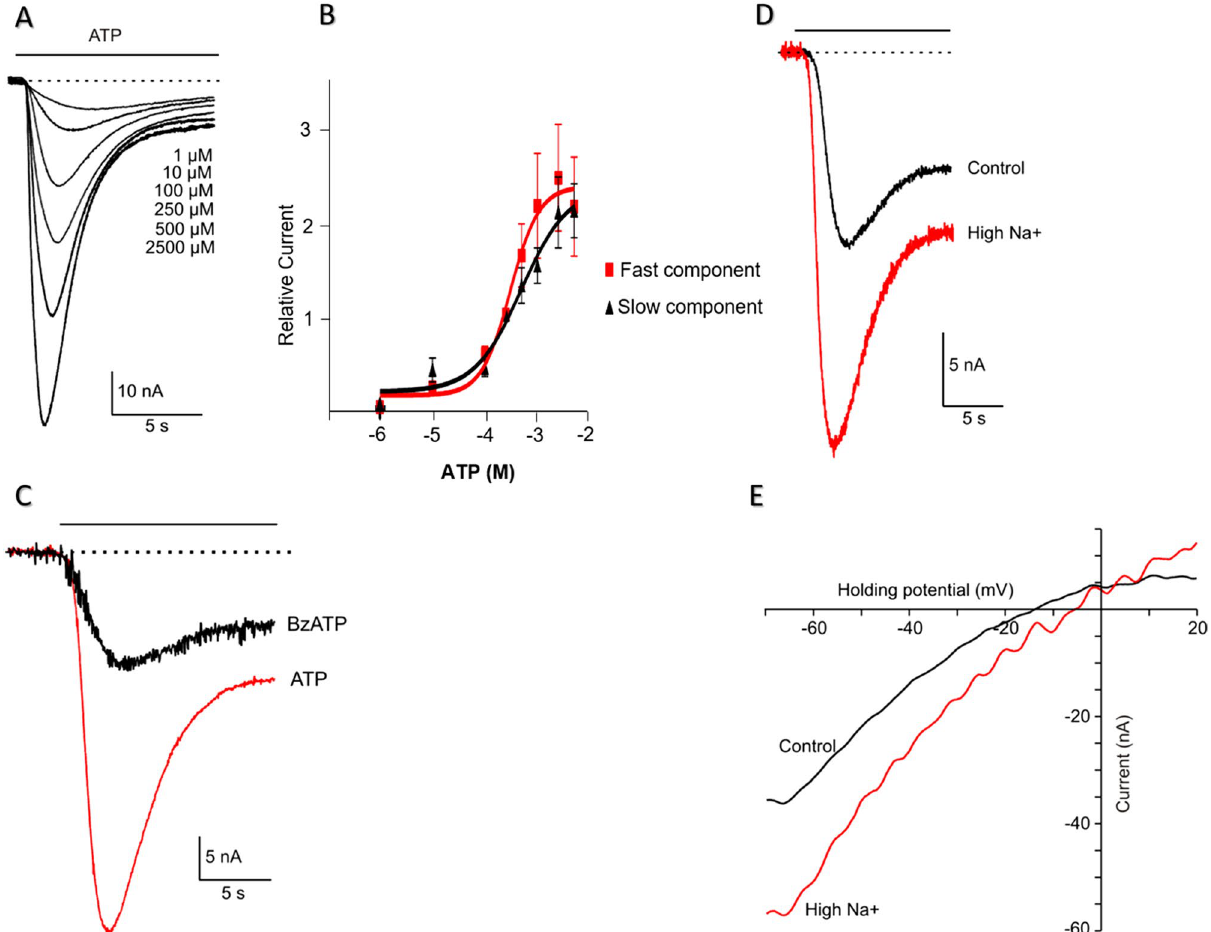
Figure 3. Functional expression of recombinant Ac P2X receptors in Xenopus oocytes. ( A ) Examples of currents recorded in response to different concentrations of ATP (HP = − 70 mV, agonist application indicated by the solid line ) . ( B ) Dose–response curves for ATP receptor activation. Mean currents were normalized to the response given by 250 μM ATP ( n = 7, oocytes). Serially increasing concentrations of ATP were applied to oocytes for 15 s at 6-min intervals. Symbols represent mean ± S.E. Continuous line for ATP represents data fitted using the equation I = I max /[1 + (IC50/L) nH ], where I is the actual current for a ligand concentration (L), nH is the Hill coefficient, and I max is the maximal current (IC50 fast = 306.0 μM, IC50 slow = 497.4 μM; nH fast = 1.58, nH slow = 0.97 ). C . Two-electrode voltage-clamp recordings from oocytes expressing Ac P2X receptors. Representative inward currents recorded in response to ATP (red trace) and the 250 μM of Bz-ATP (HP = − 70 mV, application indicated by the solid line) ( n = 8, oocytes). ( D ) Recordings of ATP-induced current (250 μM, ATP) in the presence of normal [Na + ] (96 mM) and with elevated extracellular Na + (144 mM; red trace); HP = -70 mV( n = 6, oocytes). ( E ) Ramp voltage-clamp protocol from − 70 mV HP to 20 mV in the presence of 250 μM ATP. The plots of the subtracted current (a current in the presence of ATP minus the current in the absence of ATP) against voltage during the ramp. The red trace—high [Na + ], 144 mM. According to the Nernst equation, the reversal potential was shifted by 10.2 ± 1.3 mV to the + direction of the holding potential (n = 6,